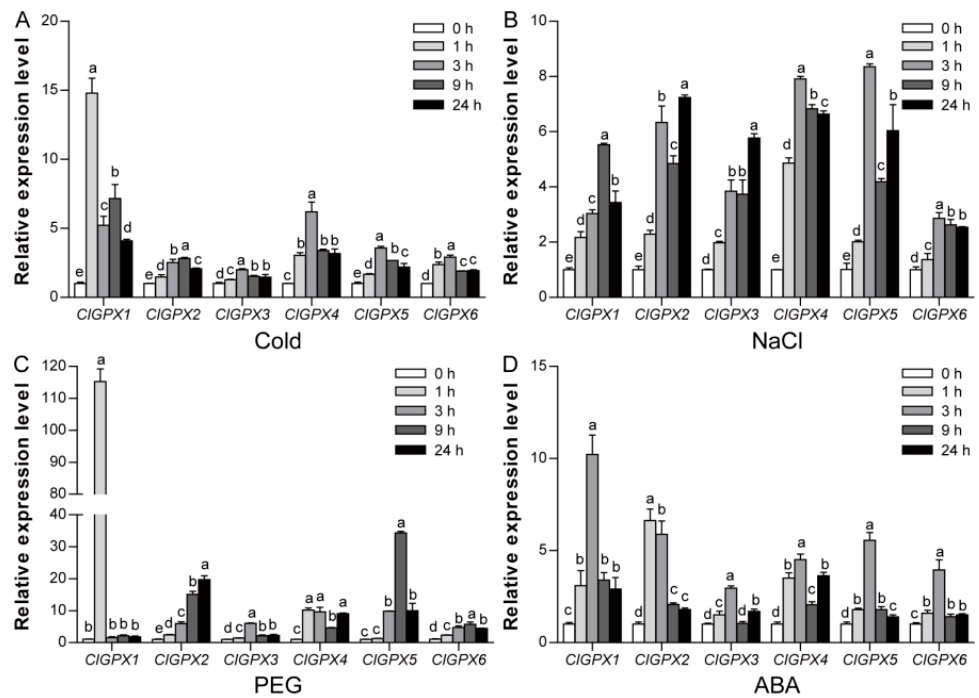
Figure 7. qRT-PCR analysis of the expression profiles of ClGPX genes in the leaves of watermelon under ( A ) cold, ( B ) salt, ( C ) drought, and ( D ) ABA treatments. The expression value of control sample (0 h) was normalized to 1. Error bars were SD of three biological replicates. Different letters indicate statistically significant differences (Tukey’s test with a p < 0.05).